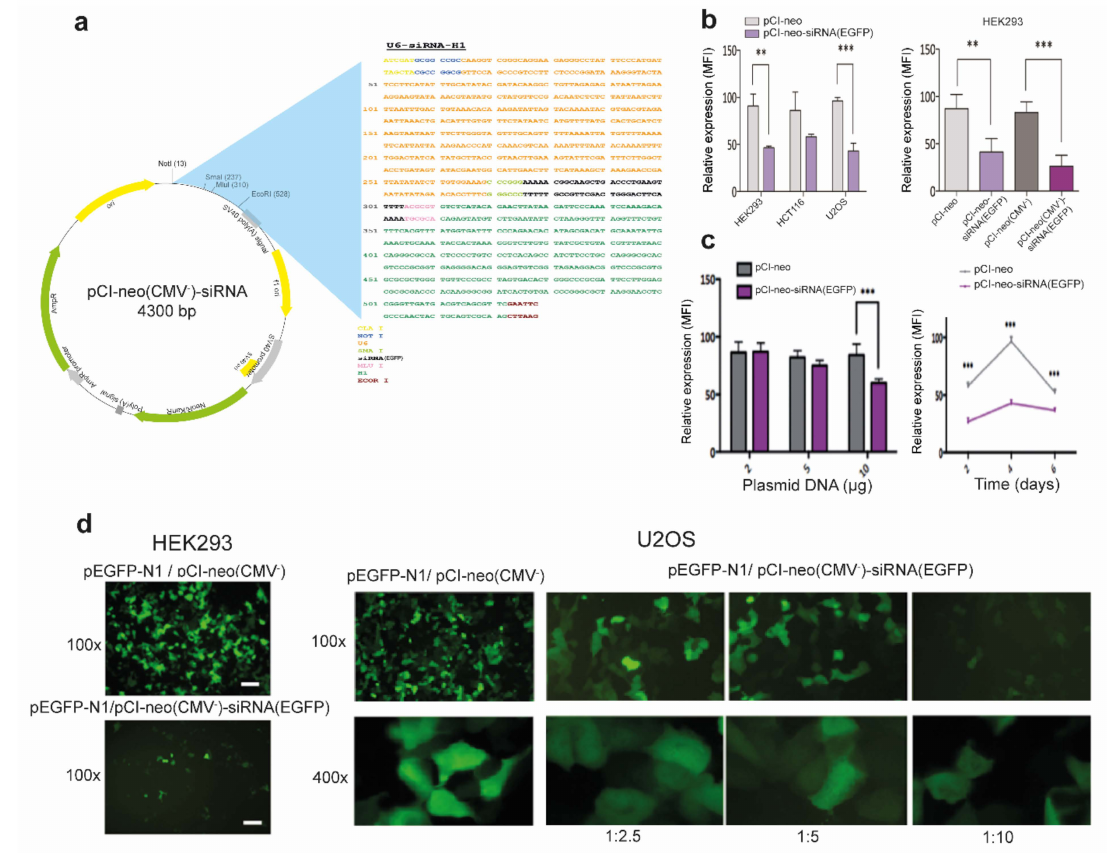
Figure 1. Functional validation of pCI-neo(CMV − )-siRNA knock-down efficacy in epithelial cells. ( a ) Scheme of the pCI- neo(CMV − )-siRNA expression vector. The upper right side shows a detail of the cloned convergent expression cassette holding the U6 and H1 polymerase III promoters in opposite orientation substituting the CMV promoter. ( b ) Functional characterization of the convergent expression system for siRNA production. Left: co-transfection of pEGFP-N1 and pCI-neo or pCI-neo-siRNA(EGFP) (1:5) in HEK293, HCT116 and U2OS cells. Right: co-transfection of pEGFP-N1 and pCI-neo, pCIneo-siRNA(EGFP), pCI-neo(CMV-), or pCI-neo(CMV-)-siRNA(EGFP) (all at 1:5 ratio) in HEK293 cells. ( c )